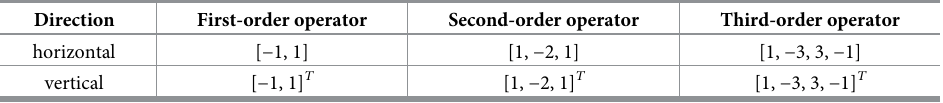
Table 1. Six difference operators. They are divided into horizontal and vertical operators, and each directional set consists of first-order, second-order and third-order